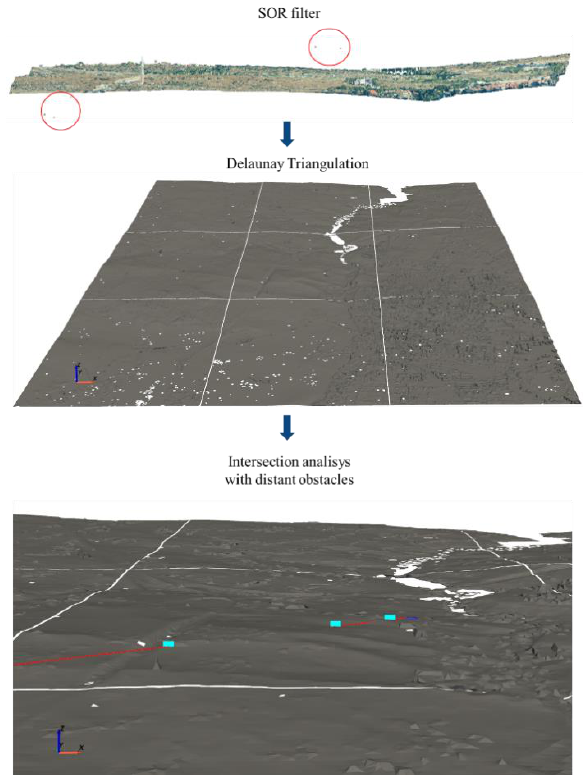
Figure 5. ALS point clouds. The blue square indicates the location of the roundabout